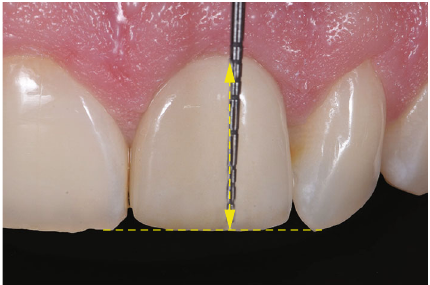
Figure 16: MBML measurement on a calibrated intraoral photograph with reference lines.